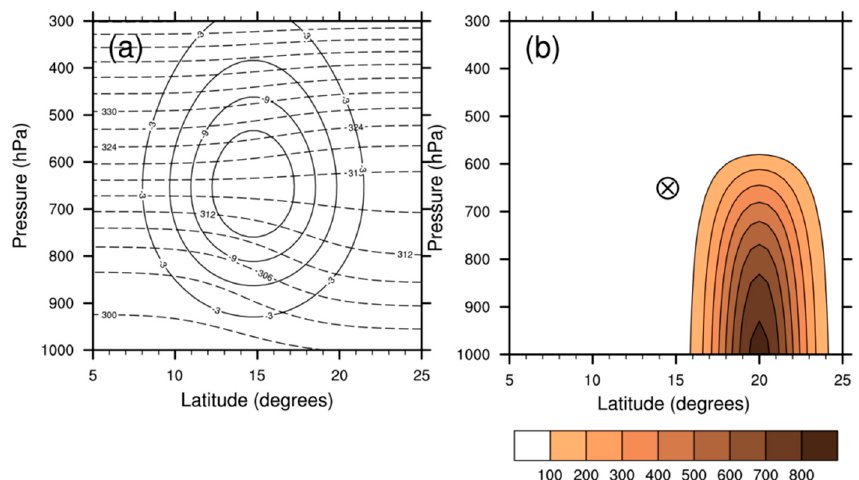
Figure 4. ( a ) Basic state zonal wind (solid) and potential temperature (dashed). Contour interval: 2 ms − 1 for the wind and 3 K for the temperature. ( b ) Basic state dust mixing ratio for the sum of the 12 particle sizes. Color interval: 100 µg kg − 1 . The African easterly jet (AEJ) core is denoted by ‘ ⦻ ’. ’.